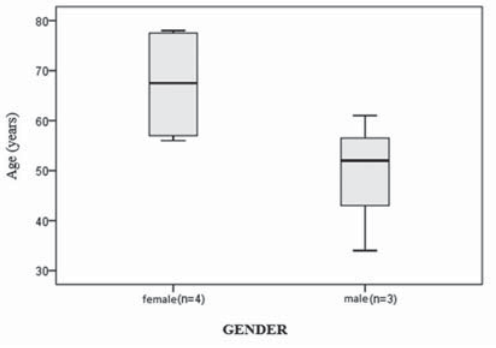
FIGURE 1. Age distribution in patients with C.diffi cile infection